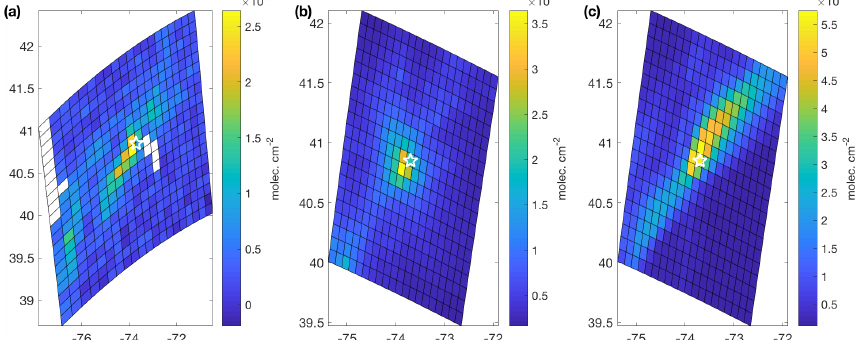
Figure 5. A comparison of OMI SCDs (a) and WRF monthly average (b) and daily (c) VCDs. The star marks the location of New York, NY, USA. Data are from 29 September